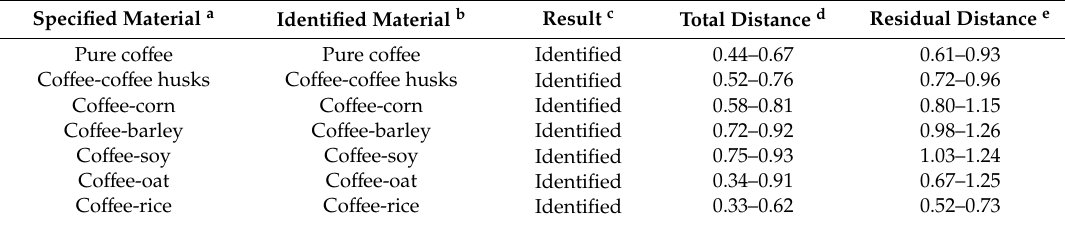
Table 3. Validation results of the SIMCA